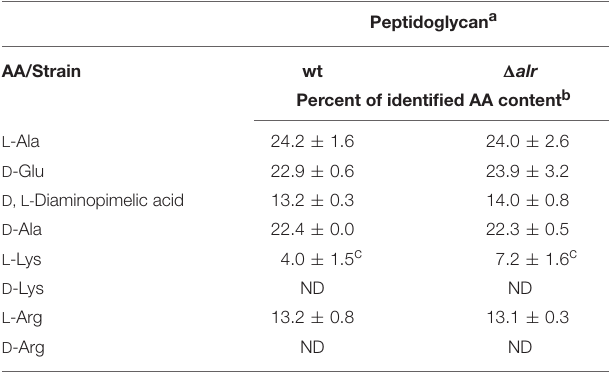
TABLE 1 | AAs detected in peptidoglycan and culture